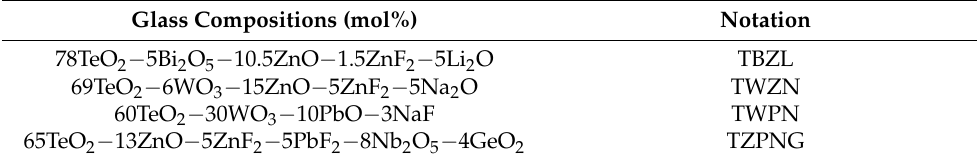
Table 1. Core and cladding glass compositions of the fluorotellurite fibers. Glass Compositions